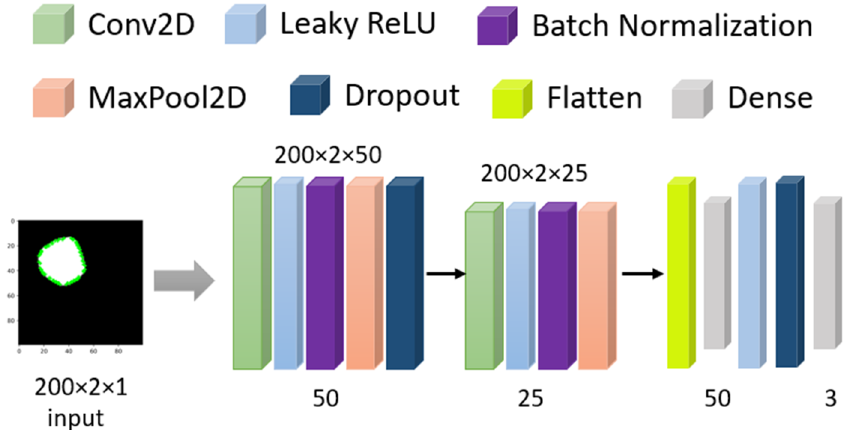
Figure 5. Model architecture for Masked images.